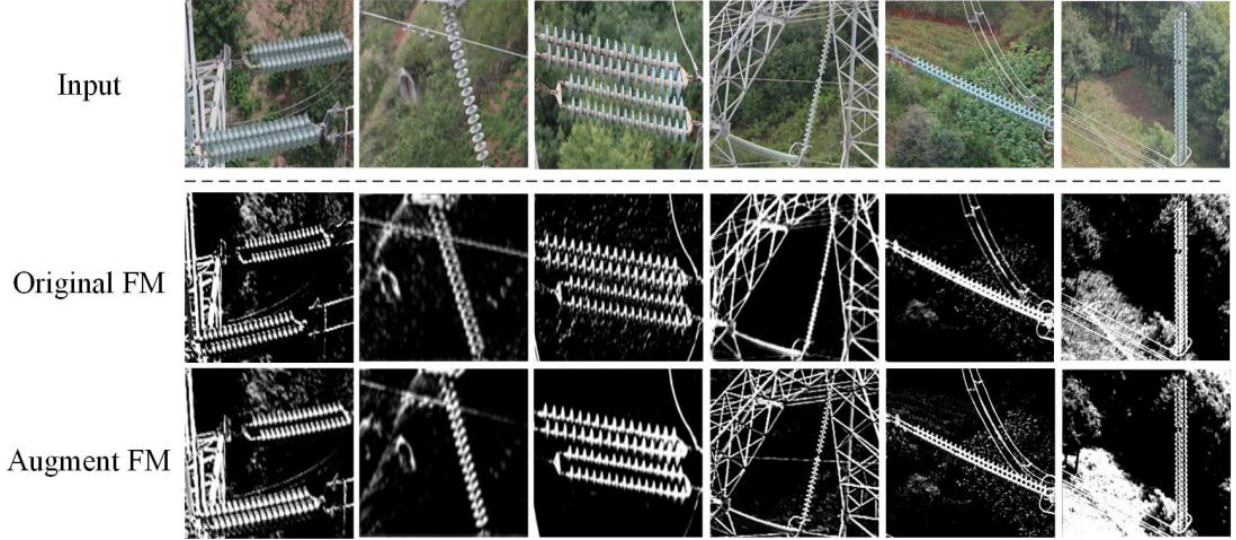
Figure 3. Input, Original FM, and Augment FM represent the original insulator image, the feature map of the ID-YOLO output, and the feature map of the Siamese ID-YOLO output, respectively. The features of the insulators in the feature map output by Siamese ID-YOLO are more pronounced, which is beneficial to improving the effectiveness of insulator detection.